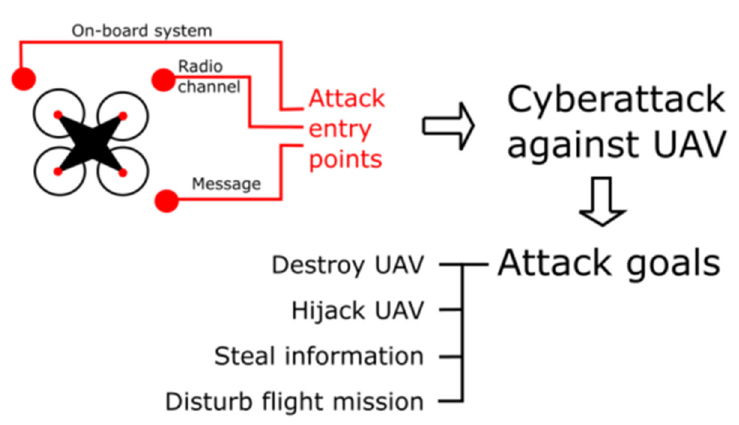
Figure 8. Cyberattacks against UAV.